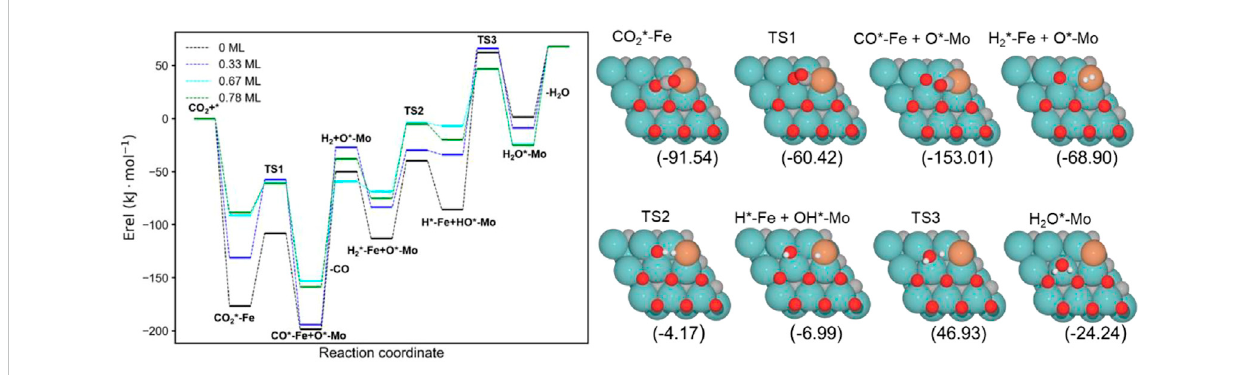
FIGURE 4 Energy pro fi le of the RWGS reaction on Fe/Mo 2 C with different O ML coverages; black, blue, cyan, and green lines indicate surface oxygen coveragesof0,0.33,0.67,and0.78,respectively.Theintermediateandtransitionstatestructuresandtheirenergiesareshownontherightforthe0.67O ML case. Energies are referenced against the sum of the initial reactants ’ energy in kJ mol – 1 (E rel